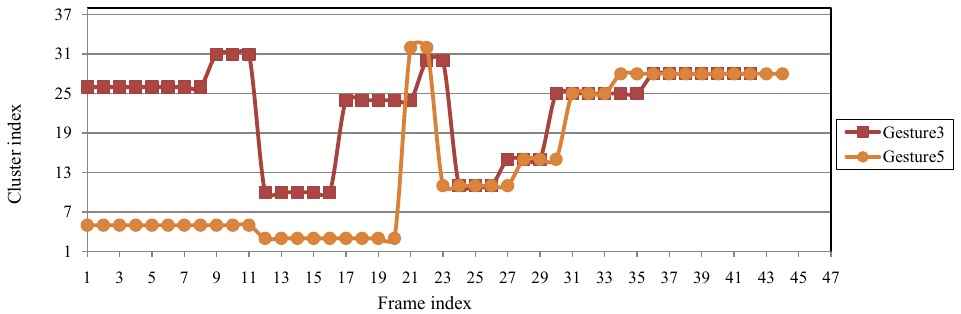
Figure 3. The cluster trajectory of the gestures for ‘3’ and ‘5’ with respect to to their combined features ( Lc , Lsc , θ ) 1 , θ 2 , θ 3 , V